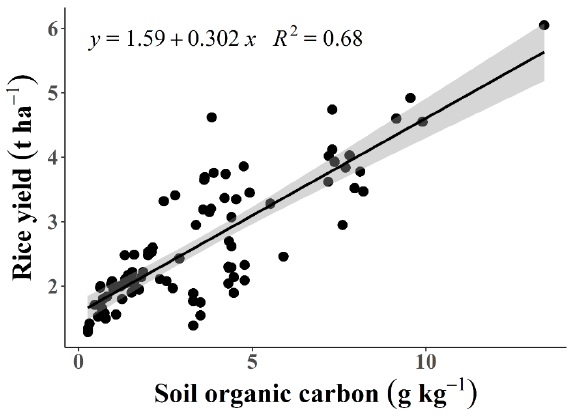
Figure 8. Correlation of soil organic carbon of rice-based system paddies and the production yield by reference observations in Northeast region, Thailand ( n = 89) (within the range of 0–40 cm depth) [41,49–70].